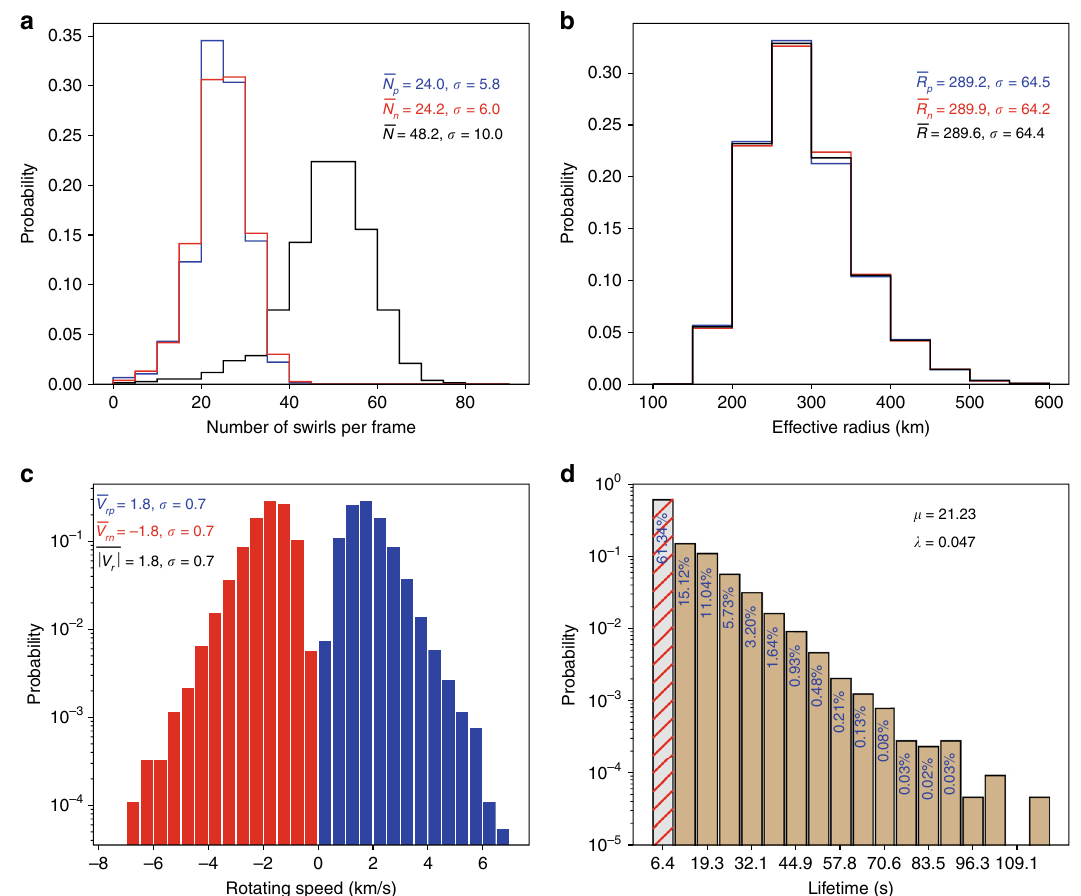
Fig. 2 Statistics of swirls detected from the SOT Ca II H line core observations. a denotes the distribution of number of swirls per frame, with b the effective radii, c the average rotating speeds at edges and d the lifetimes of all swirls. Blue (red) curves, bars and texts in the fi rst three panels represent results of positive (negative) swirls. Black curves and texts are the results of all swirls. μ and λ in d are the expectation and maximum likelihood estimation 17 of the exponential rate parameter of the lifetime, respectively. The left most bar is stripped, because lifetimes less than twice of the cadence are not measured but estimated given the limitation on the cadence. These events have also been excluded when estimating μ and λ . Source data are provided in the